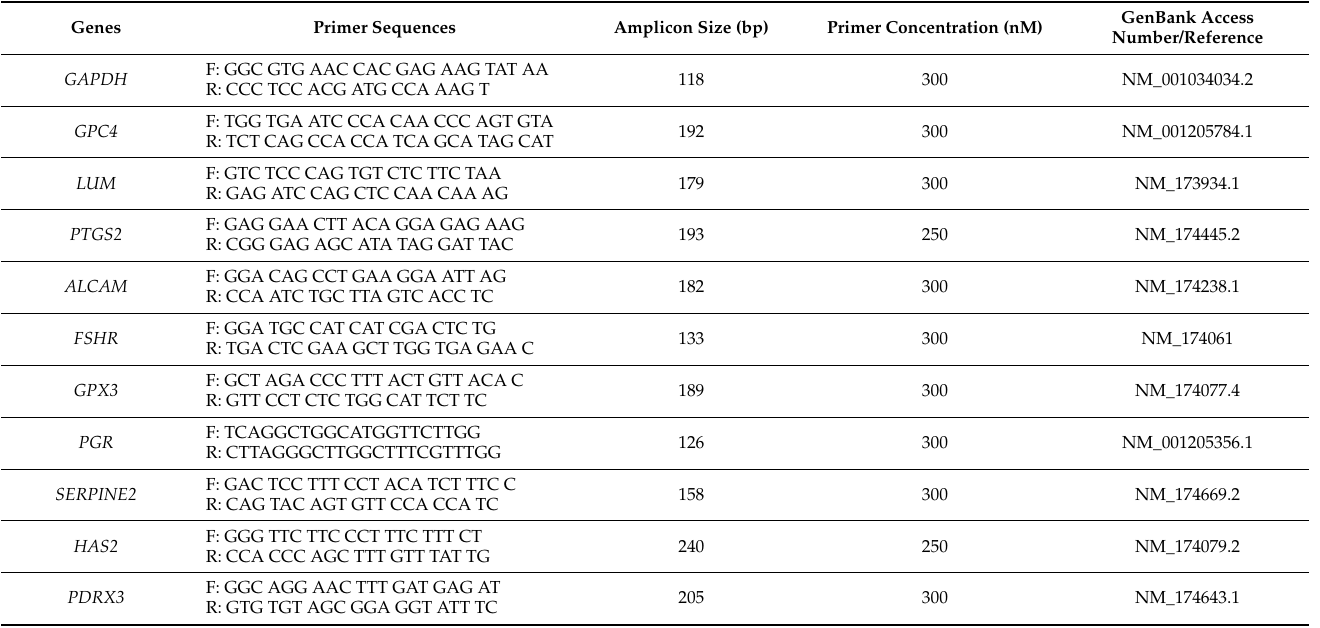
Table 1. Information about the specific primers used for the amplification of gene fragments for the quantitative polymerase chain reaction